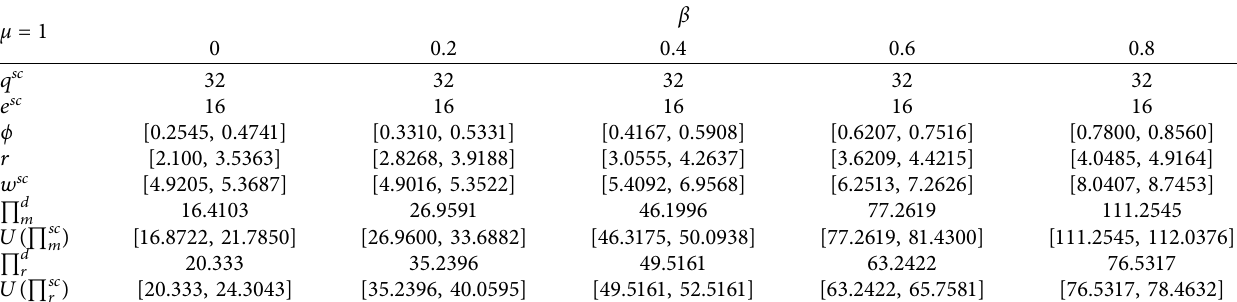
Table 3: The effect of the cognitive biases on the coordination of the supply